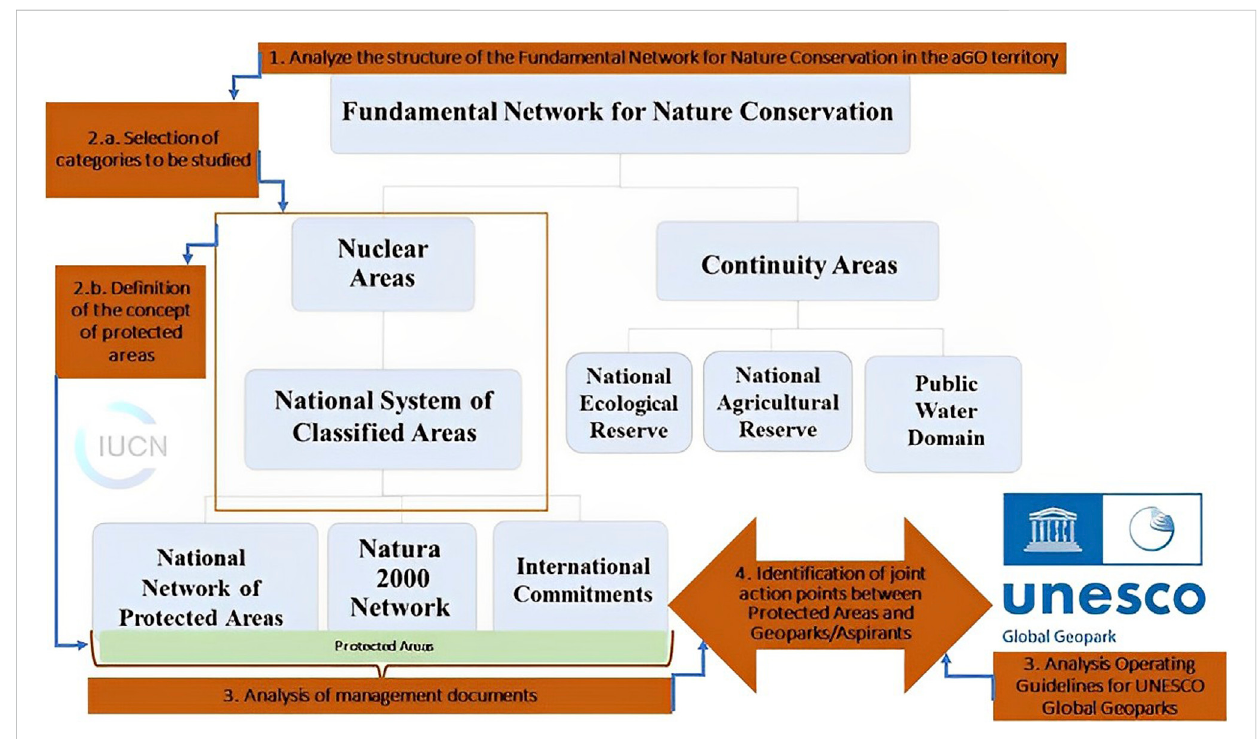
FIGURE 10 Research methodology. Source: elaboration based on Decree-Law No. 142/2008. On July 24, adapted by Nunes et al.